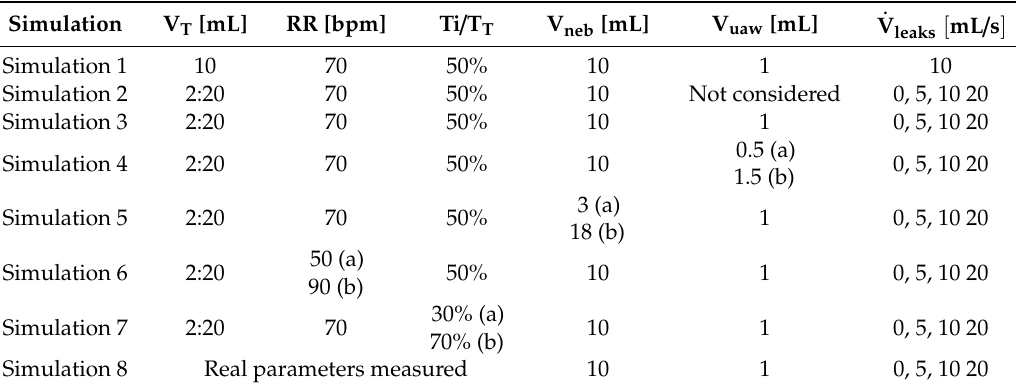
Table 1. List of the parameters set for each